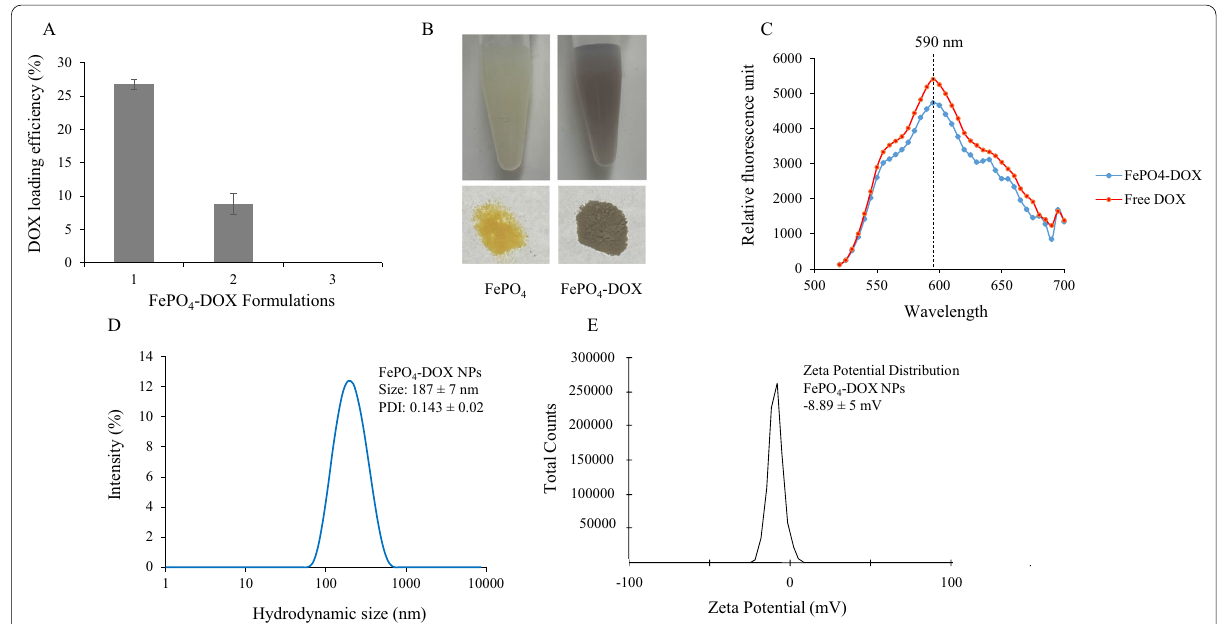
Fig. 2 Doxorubicin (DOX) loading in FePO 4 NPs and characterization of FePO 4 -DOX. a DOX loading efficiency in three different formulations of FePO 4 NPs and DOX, b pictorial representation of the change of color from yellow to brown after DOX loading in FePO 4 to formulate FePO 4 -DOX, c emission spectra characterization of DOX loaded FePO 4 NPs (FePO 4 -DOX) after excitation at 480 nm, d hydrodynamic size distribution of FePO 4 -DOX NPs, and e zeta potential characterization of FePO 4 -DOX NPs showing surface charge (data represents mean